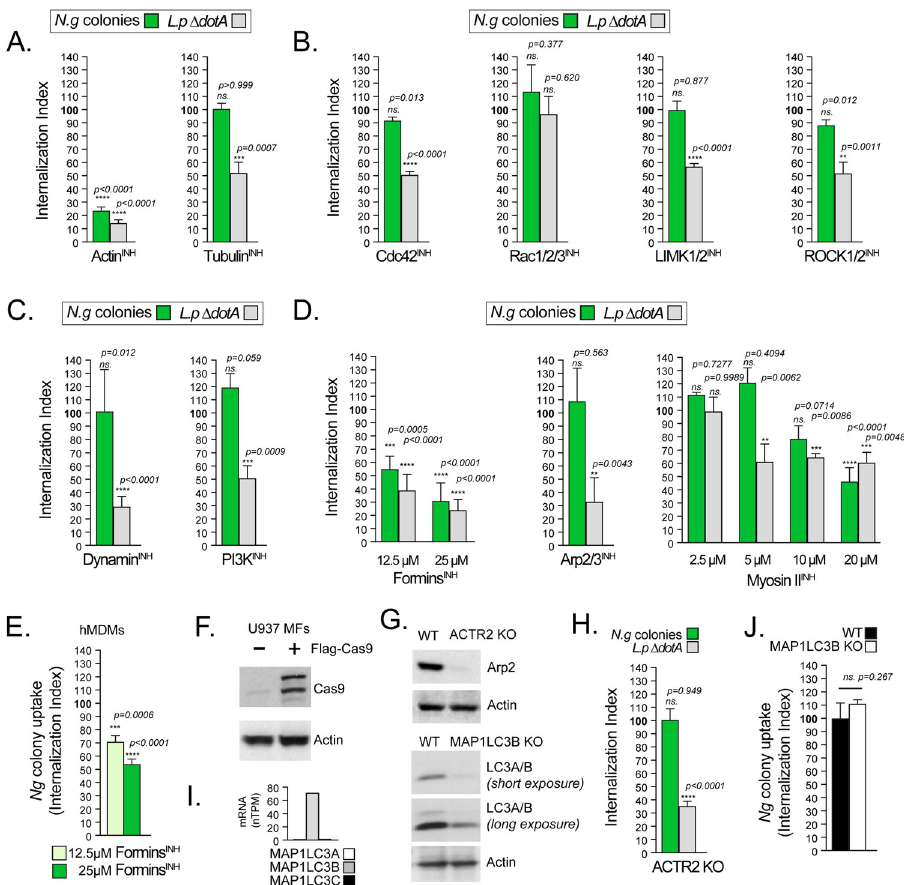
Fig 7. Gonococci enter macrophages despite a block in phagocytosis. (A-E) Gonococci internalization by U937 MFs (A-D, H and J) and hMDMs (E) requires formin-mediated actin polymerization but not canonical phagocytosis. (A-E, H and J) Quantitative analysis of bacteria uptake by macrophages using inside/out microscopy in the presence/absence of different inhibitors added 30 min prior to infection. Gonococcal infections were stopped at 8hpi and the percentage of intracellular colonies in each condition was calculated (green bars). L . pneumophila Δ dotA infections were stopped at 2hpi and the percentage of internalized bacteria was determined (gray bars). The internalization index reflects how each treatment affects uptake compared to vehicle control and was calculated for each condition by dividing the percentage of internalized objects from the treatment condition by the percentage of internalized objects from the respective vehicle control condition, which was then multiplied by 100. Inhibitors targeting: (A) actin polymerization (cytochalasin D, 5 μ M) and microtubules polymerization (nocodazole, 3 μ M); (B) the small GTPases Cdc42 (ML-141, 5 μ M), Rac1/2/3 (EHT 1864, 5 μ M) and the downstream effectors of Rho GTPase—LIMK1/2 kinases (BMS-5, 1 μ M) and ROCK1/2 kinases (GSK269962, 1 μ M); (C) the phagosome regulators Dynamin (dynasore, 30 μ M) and Phosphoinositide-3 kinase (LY294002, 10 μ M); (D) actin polymerization regulators formins (SMIFH2, 12.5 or 25 μ M), Arp2/3 complex (CK869, 10 μ M), Myosin II ATPases ((-) blebbistatin, from 2.5 to 20 μ M). (E) Decreased gonococci uptake at 8hpi by hMDMs treated with SMIFH2 as indicated. (F) Immunoblot analysis of the U937 cell line stably expressing Cas9 used for CRISPR genome editing. (G) Immunoblot validation for the loss of Arp2 in the ACTR2 KO and LC3 in the MAP1LC3B KO U937 MFs. (H and J) N . g colony internalization is not affected by the loss of (H) Arp2 or (J) LC3. (I) mRNA expression for the indicated genes in U937 cells from RNAseq presented in normalized transcript per million (nTPMs). Data obtained from the Human Atlas Project [112]: MAP1LC3A (https://www. proteinatlas.org/ENSG00000101460-MAP1LC3A/cell+line); MAP1LC3B (https://www.proteinatlas.org/ ENSG00000140941-MAP1LC3B/cell+line); MAP1LC3C (https://www.proteinatlas.org/ ENSG00000197769-MAP1LC3C/cell+line). (A-E, H and J) Means from at least three biological replicates ± SD. At least 100 N . g colonies or L . p Δ dotA bacteria for each condition were scored. The statistical significance of the differences between the internalization index from inhibitor-treated cells and the vehicle-treated cells for each condition were calculated using the unpaired T-test (A-C, D for Arp2/3INH, H and J) or one-way ANOVA (D for Formin INH and MyosinII INH , E) , not significant